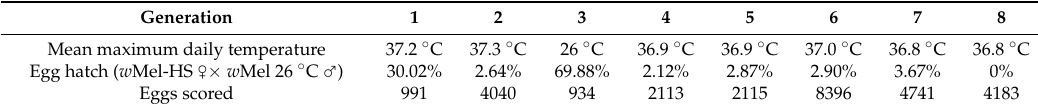
Table 1. Average maximum temperatures and egg hatch rates of w Mel-infected Ae. aegypti females for the first eight generations during the selection experiment. Females reared at the specified temperature were crossed to w Mel-infected males reared at 26 ◦ C. Generation 3 is a relaxed generation. Only eggs and egg hatch proportions from cages that contributed to the next generation are shown. Egg hatch rates were not recorded after the eighth